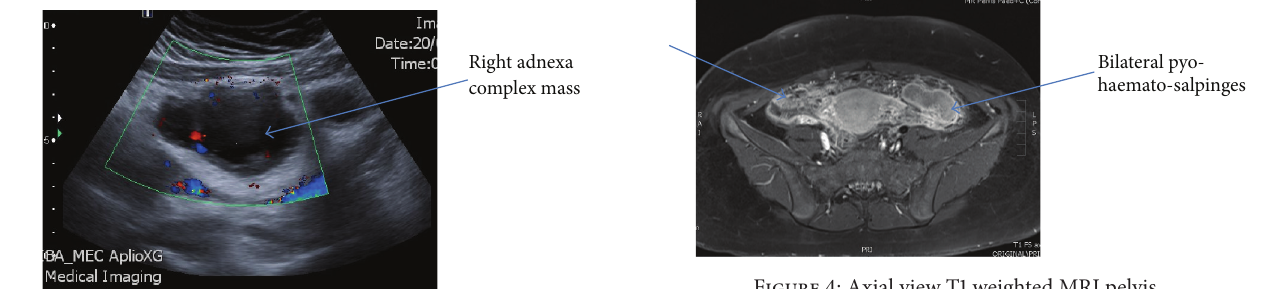
Figure 4: Axial view T1 weighted MRI